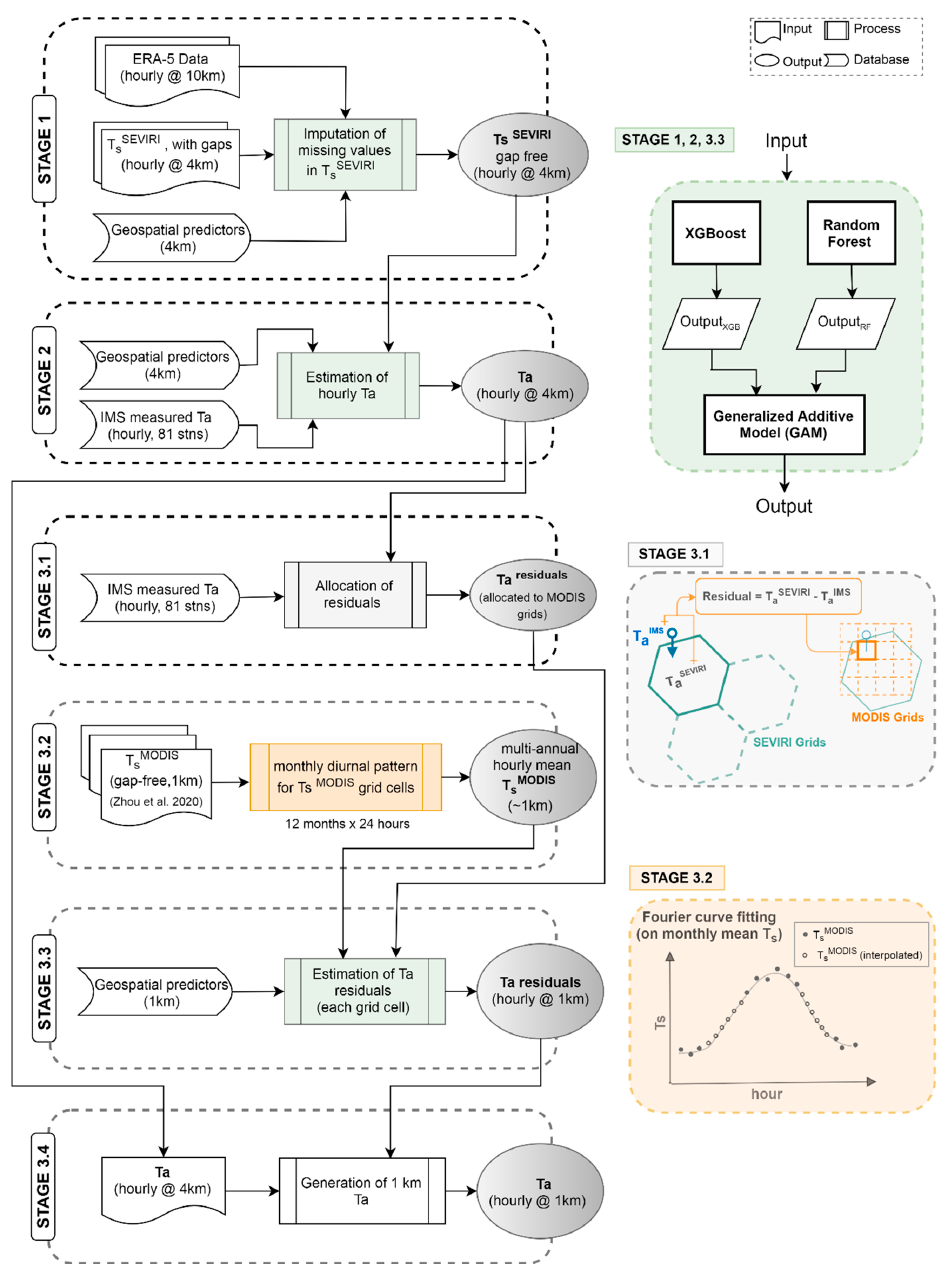
Figure 2. Flowchart of the three-stage ensemble model for estimating gridded hourly Ta at 1 × 1 km 2 . In the first stage we imputed satellite-based SEVIRI Ts values for missing Ts grid cells (obscured by cloud cover, etc.). Then we fed the imputed SEVIRI Ts for each grid cell into the Stage 2 model to predict hourly Ta at 4 × 4 km 2 . In Stage 3, residuals of the predicted Ta , i.e., difference between predicted and measured Ta (at a weather station located within the 4 × 4 km 2 SEVIRI grid cell), were allocated to the MODIS 1 × 1 km 2 gridding system (see Figure 2, Stage 3.1). We estimated Ta residuals across the entire country by taking into account the monthly mean diurnal pattern of Ts derived from the multi-annual MODIS observations from 2004–2017. By re-adding Ta residuals estimated hourly at 1 × 1 km 2 to the 4 × 4 km 2 Ta from Stage 2, we obtained the hourly Ta estimation at 1 × 1 km 2 .